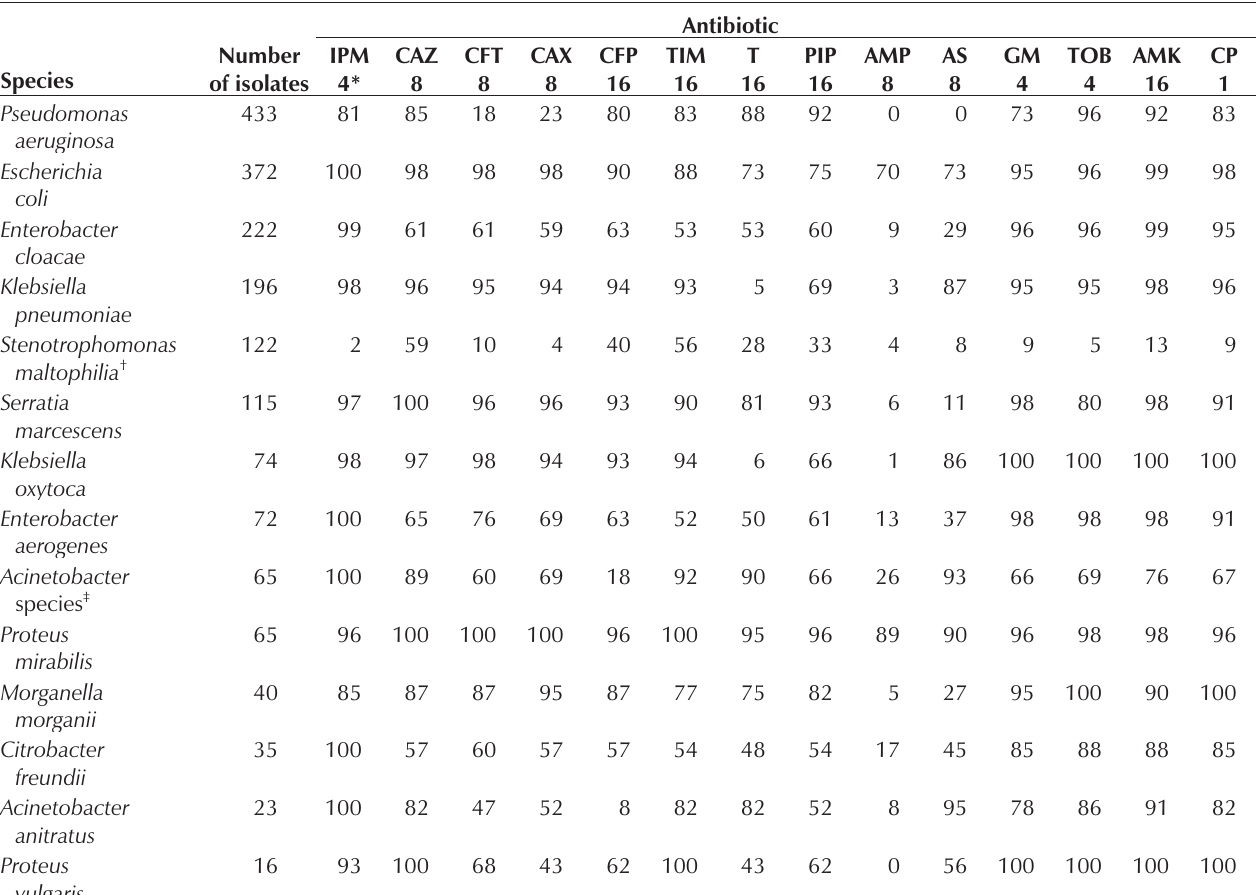
Frequency and percentage of susceptibility of common isolates (20 centres, 1993, initial and repeat